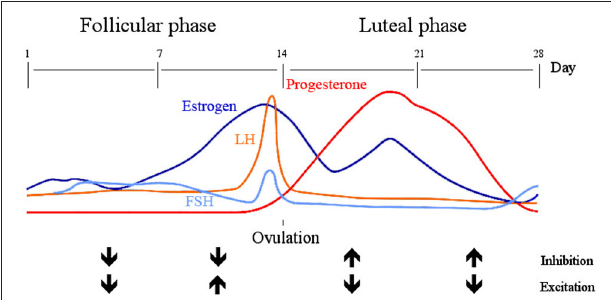
FIGURE 1 | Inhibition and excitation across the menstrual cycle. The early follicular phase (day 1 –the start of menstruation—until day 7) is characterized by low levels of estrogen and progesterone, during which both inhibition and excitation are low. With an increase in estrogen from day 7–14, luteinizing hormone (LH) and follicular stimulating hormone (FSH) peak and stimulate ovulation on day 14. During this late follicular phase inhibition is low and excitation high, which reverses in the following 14 days (early luteal phase). Estrogen, in particular estradiol is now moderately high but progesterone